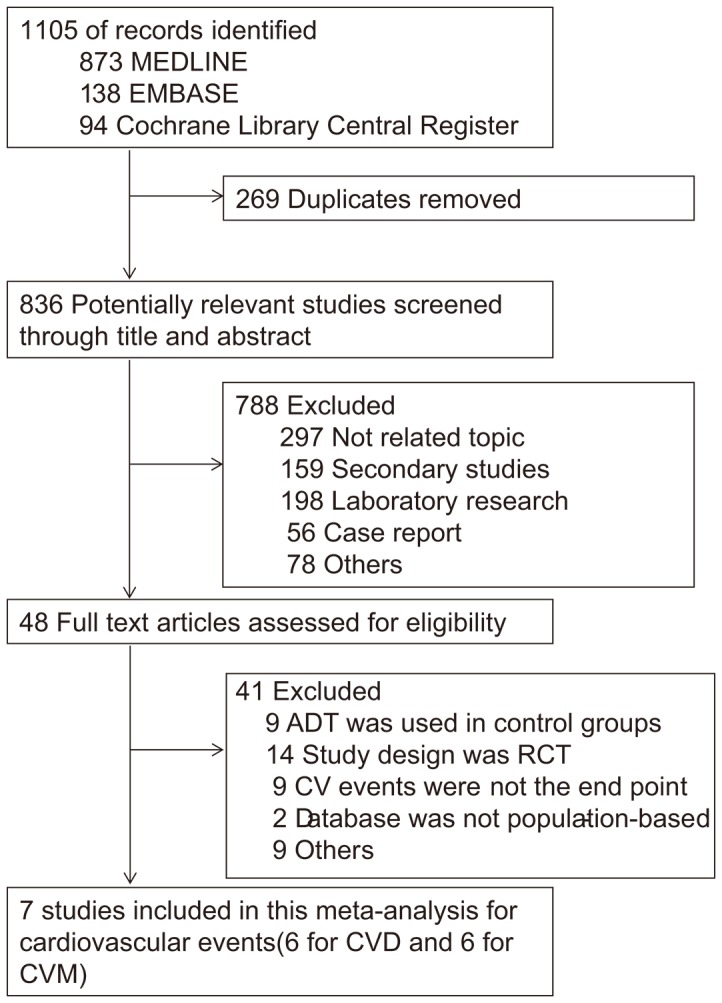
Flow Diagram of Search Strategy and Study Selection.